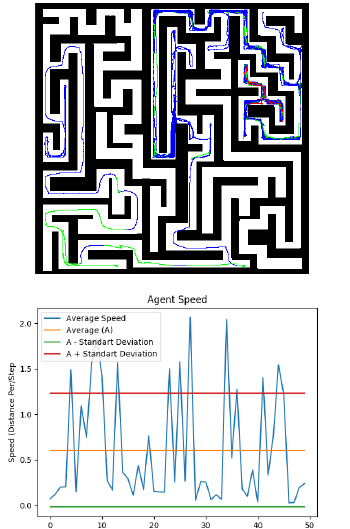
Figure 14. (a) The agent emotional state, and (b) the agent speed with the emotional model’s configurations equal to that shown in row 1 of Table